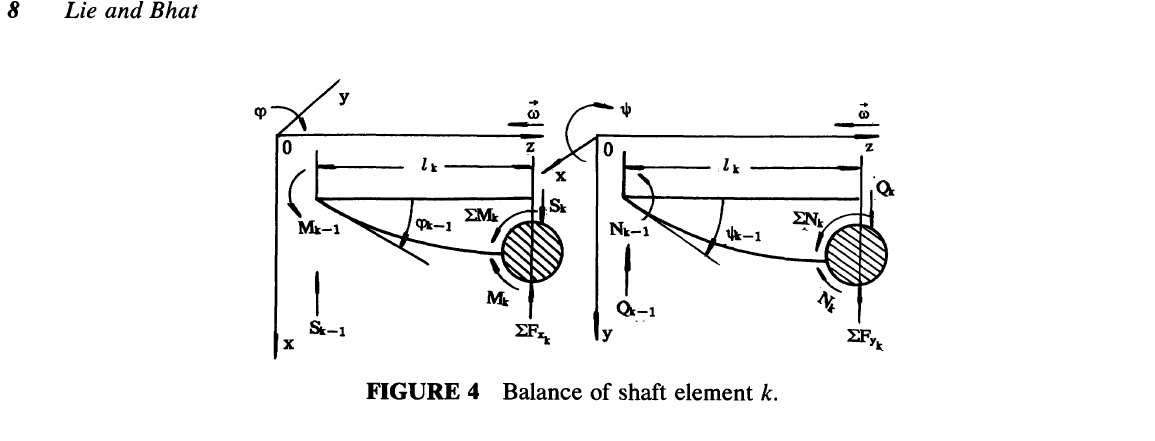
FIGURE 4 Balance of shaft element